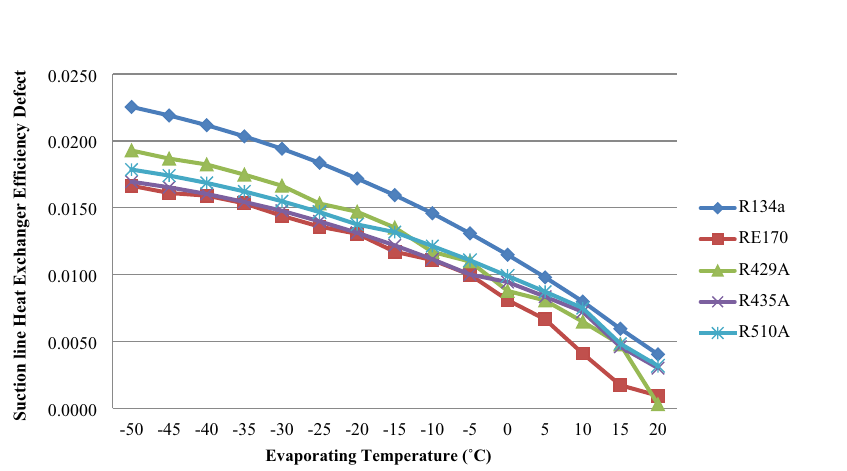
Figure 8. Evaporator efficiency defect as a function of evaporator temperature.